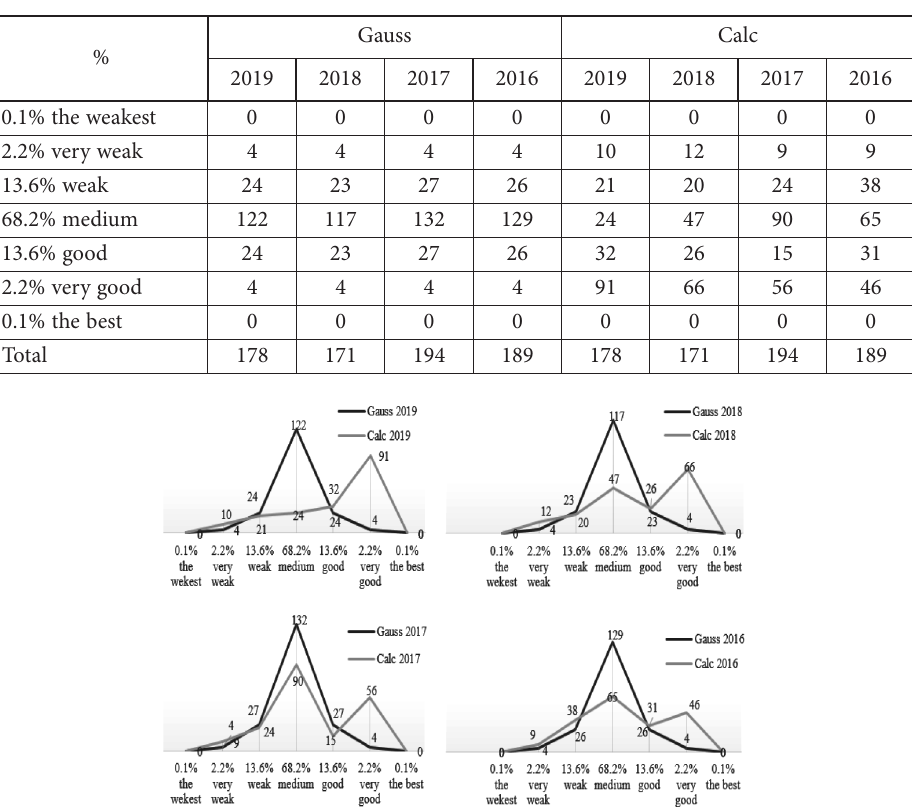
Table 6. Comparing the values obtained with the Gauss distribution